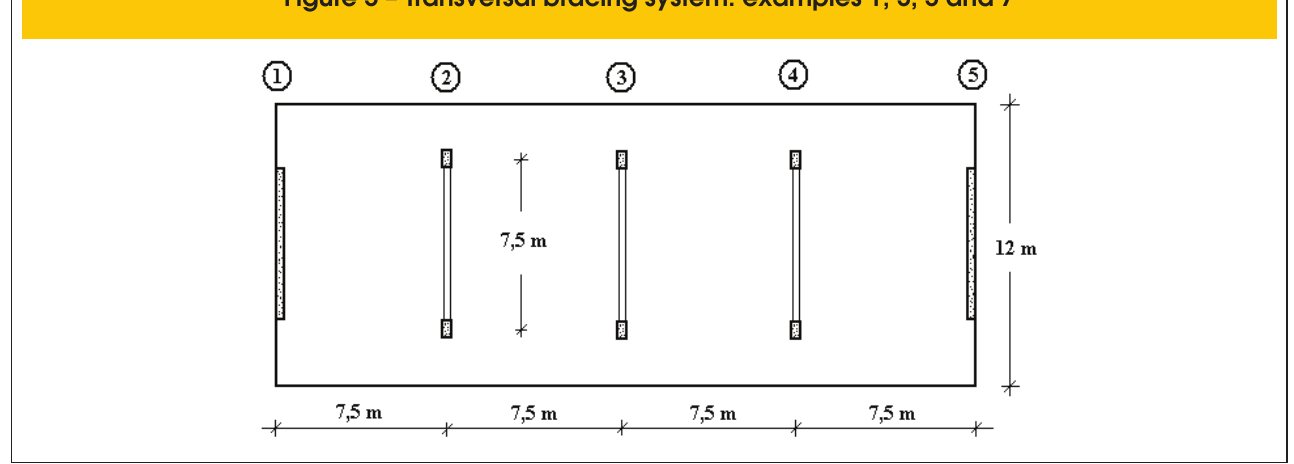
Figure 5 – Transversal bracing system: examples 1, 3, 5 and 7